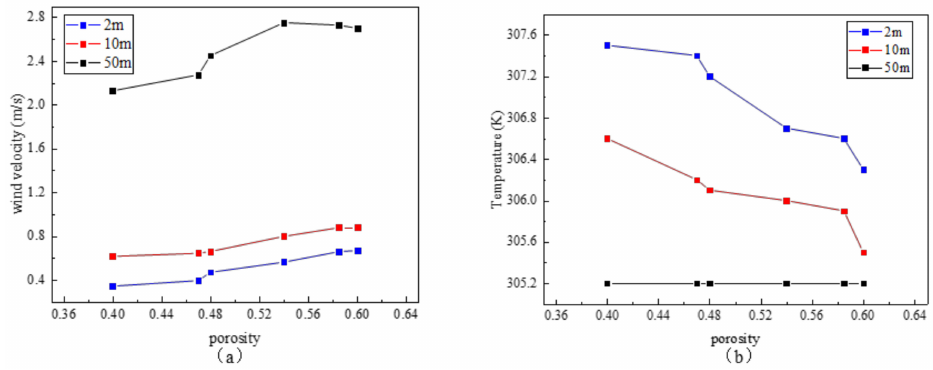
Figure 13. Effect of porosity on ( a ) wind velocity and ( b ) temperature at different